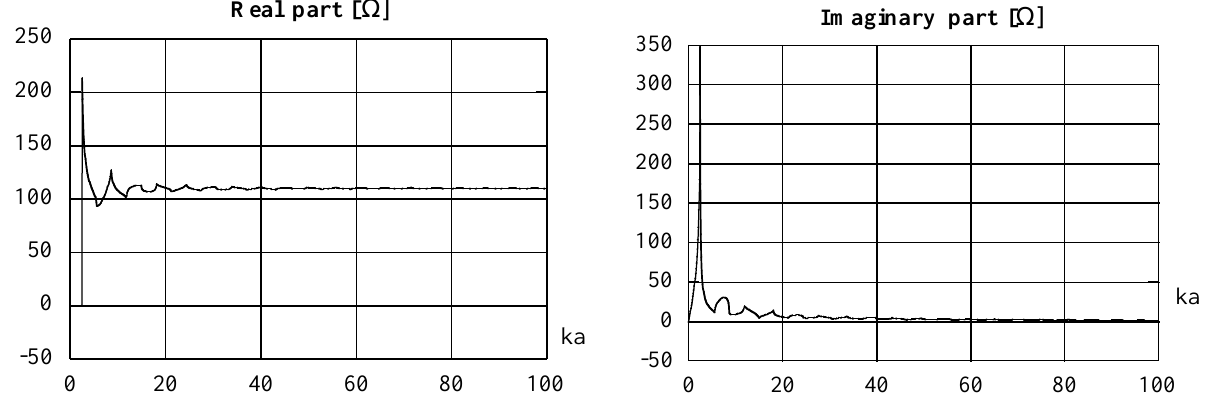
FIG. 18. Real and imaginary parts of the longitudinal coupling impedance in the case (cid:119) (cid:173) (cid:50) (cid:121) (cid:53) and b (cid:173) (cid:49) .